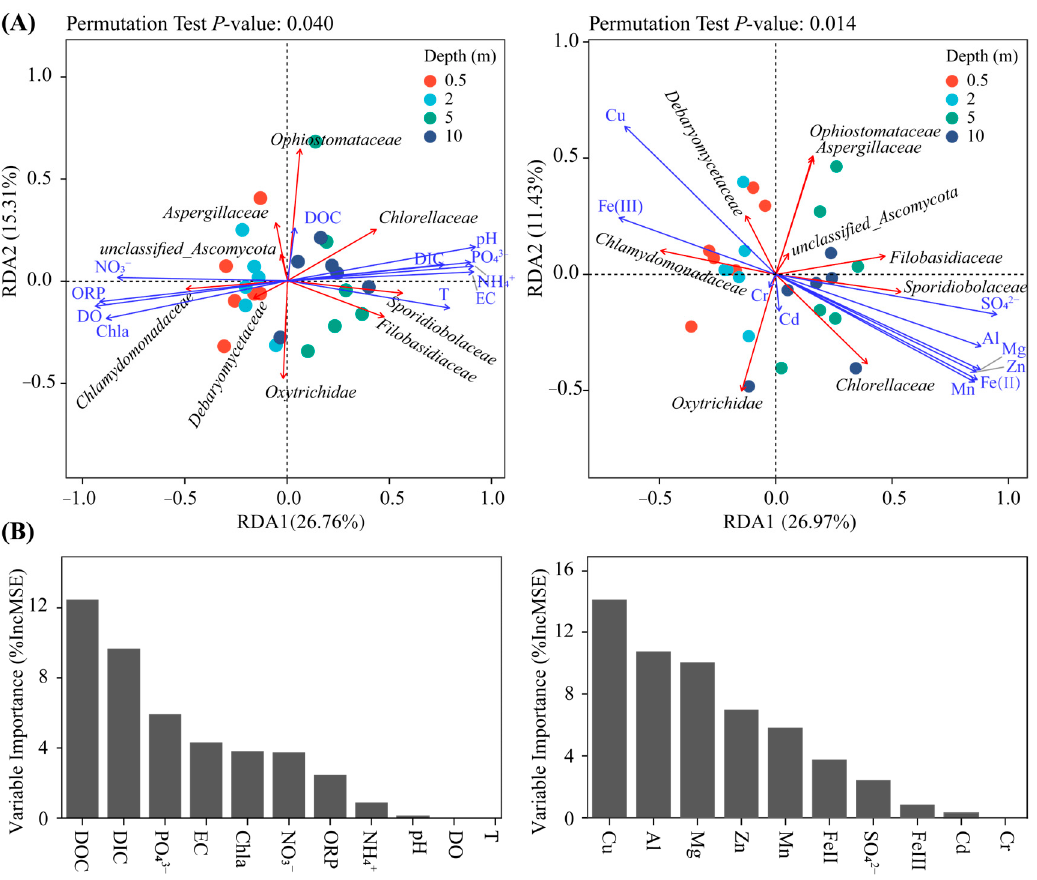
Figure 4. Redundancy analysis (RDA) of eukaryotic communities and environmental factors ( A ). Blue arrows with different lengths denote relative correlations of different independent variables with the biological factors. Red arrows of different lengths indicate different content of family level groups. Random Forest model output relating geochemical parameters to eukaryotic community richness in four depths ( B ) .